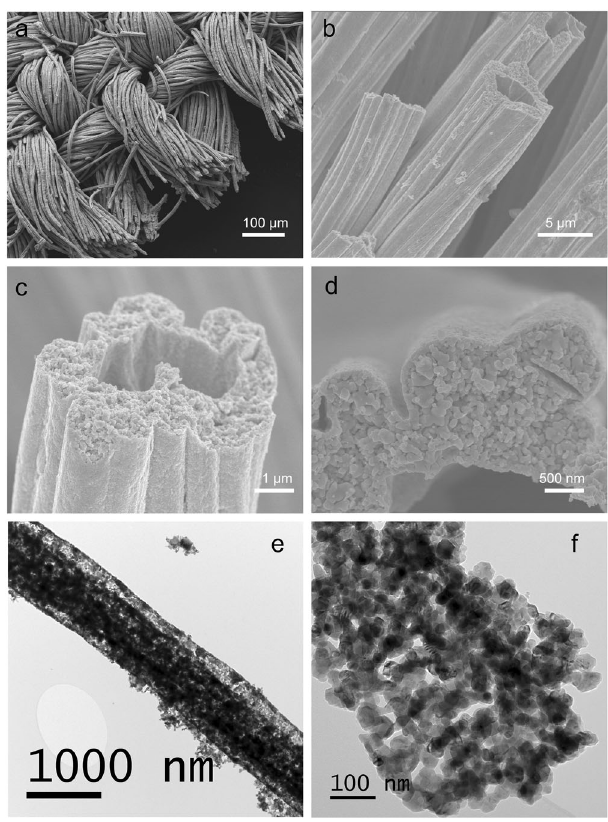
Fig. 4 Nano fi ber-structured PNC mesh with high porosity and active nanoparticles. a – d Scanning electron microscopy images of the electrode mesh with different magni fi cation showing hollow- fi ber-like string self- architectured to form mesh structure. e , f Transmission electron microscopy images of a single nano fi ber composed of ~50 nm